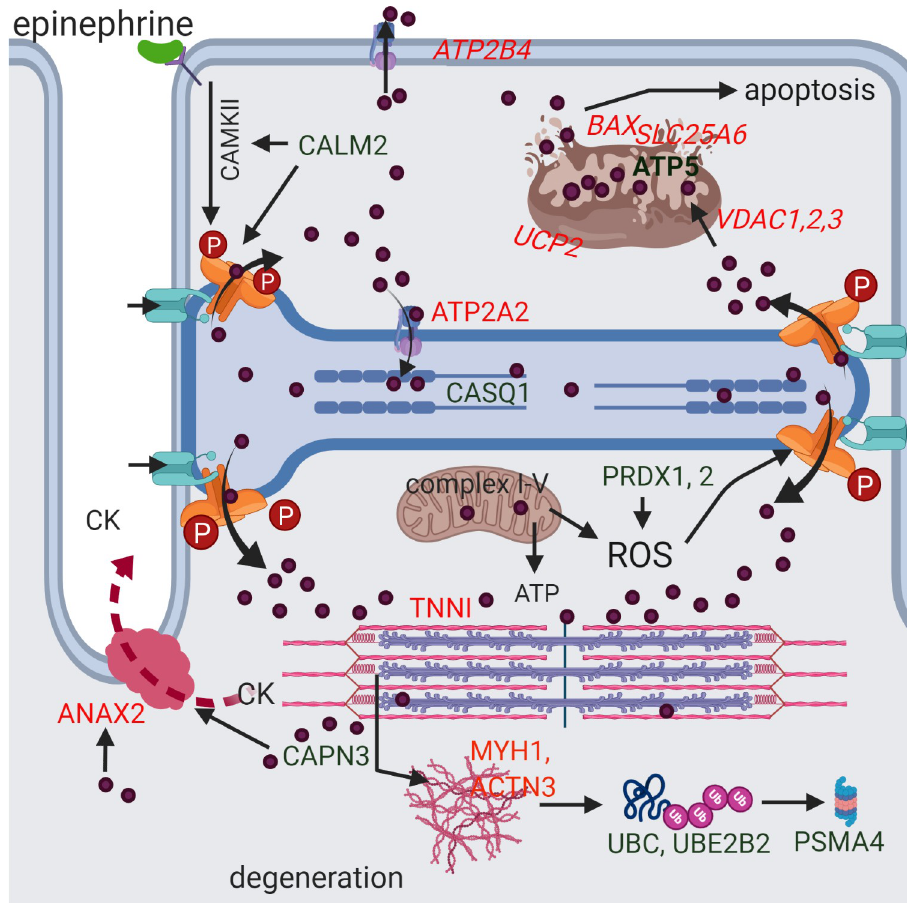
Fig 2. A potential scenario for the development of rhabdomyolysis in RER-susceptible horses derived from differentially expressed proteins and genes. Green indicates increased and red decreased differential expression. Genes are italicized. A stressful environment is proposed to induce hyper-phosphorylation of RYR1 through beta adrenergic (epinephrine mediated) activation of calmodulin kinase II (CAMKII) which is stimulated by the DEP calmodulin (CALM2). This and other potential post-translational modifications of RYR1 (oxidation/nitrosylation) allow excessive Ca 2+ (purple circles) release of high sarcoplasmic reticulum Ca 2+ stores in RER-susceptible horses through RYR1 (orange) when RYR1 opening is stimulated during exercise by the voltage gaited Ca 2+ channel in the t- tubule (turquoise). Myoplasmic Ca 2+ interacts with troponin I (TNNI) and, when not adequately pumped back into the sarcoplasmic reticulum (ATP2A2) or out of the cell ( ATP2B4 ), Ca 2+ produces persistent contracture of the sarcomere (pink and purple). Mitochondria buffer myoplasmic Ca 2+ through VDAC uptake where Ca 2+ stimulates ATP production. However, in excess, Ca 2+ uncouples ( UCP2) oxygen consumption from electron transport and ATP production and releases reactive oxygen species (ROS). Antioxidants such as peroxiredoxin (PRDX1, PRDX2) counteract ROS to prevent oxidative stress. Excessive mitochondrial matrix Ca 2+ results in formation of the membrane transition pore ( BAX , SLC25A6 , ATP5), loss of membrane potential, release of cytochrome C and apoptosis. Calcium activation of proteases such as calpain (CAPN3) results in degradation of myofilaments, cellular proteins and cell membranes resulting in the release of muscle proteins such as creatine kinase (CK) into the blood stream. Calcium activated ANAX2 participates in repair of membranes that have increased dystrophin (DMD) and syntropin (SNTB1) content. Degraded proteins are ubiquitinated (UBC, UBE2B2) and processed in the proteasome (PSMA4). abundance (~24 million read pairs, 53% of total sequenced read pairs). The average depth of coverage per sequenced base was 60.0X ± 7.8. Of the 28,623 expressed transcripts, 96.5% were determined to be autosomal and 3.5% were mapped to the X chromosome. After filtering for low count transcripts, 14,155 (49.4%) remained for the principal component and differential expression analysis.